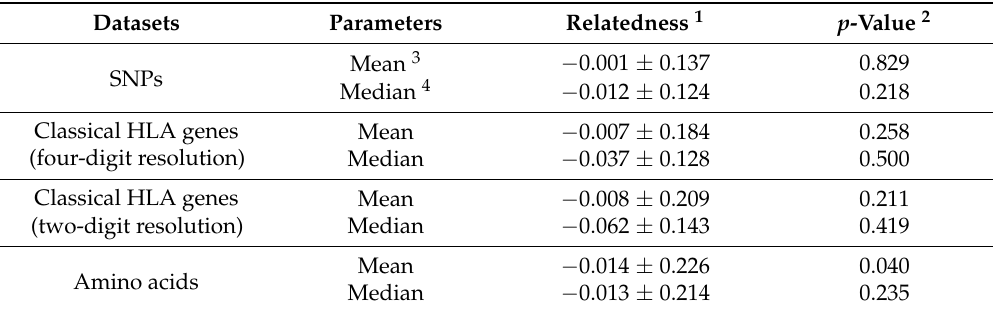
Figure 1. Distribution of relatedness coefficients (x axis) across the Major Histocompatibility Complex (MHC) region among spousal pairs. ( A ) all single-nucleotide polymorphisms (SNPs), ( B ) all eight classical human leukocyte antigen (HLA) genes (at four-digit resolution), ( C ) all eight classical HLA genes (at two-digit resolution), and ( D ) all 376 amino acid polymorphisms. Table 1. Summary of relatedness analyses across the entire MHC region calculated across three levels of genomic variation (SNPs, classical HLA genes, and amino acid polymorphisms) in the Health and Retirement Study (HRS) individuals of European ancestry.